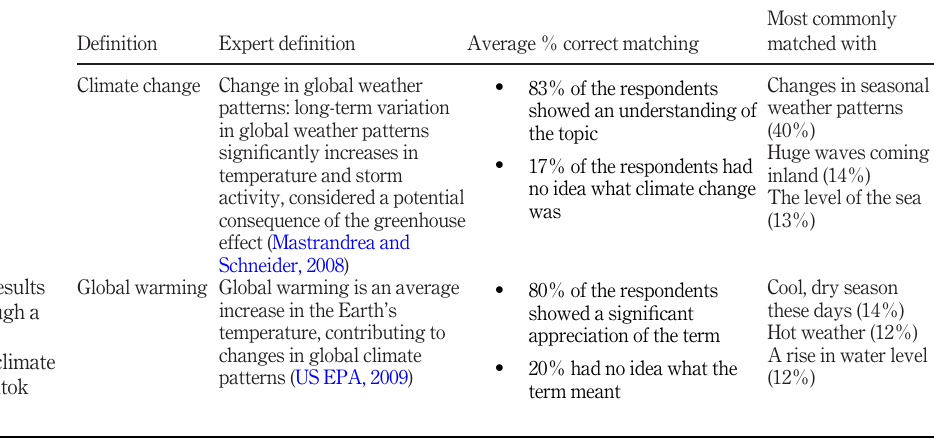
Table 3. Summary of results obtained through a survey on the perception of climate change at wantok moana